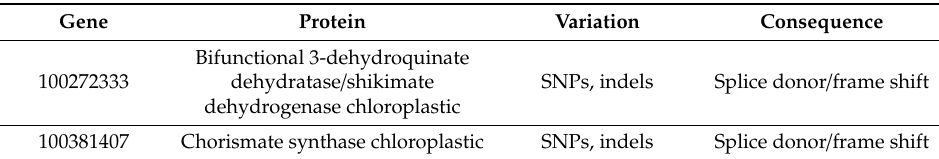
Table 3. Shikimate pathway genes affected by SNPs and indels.